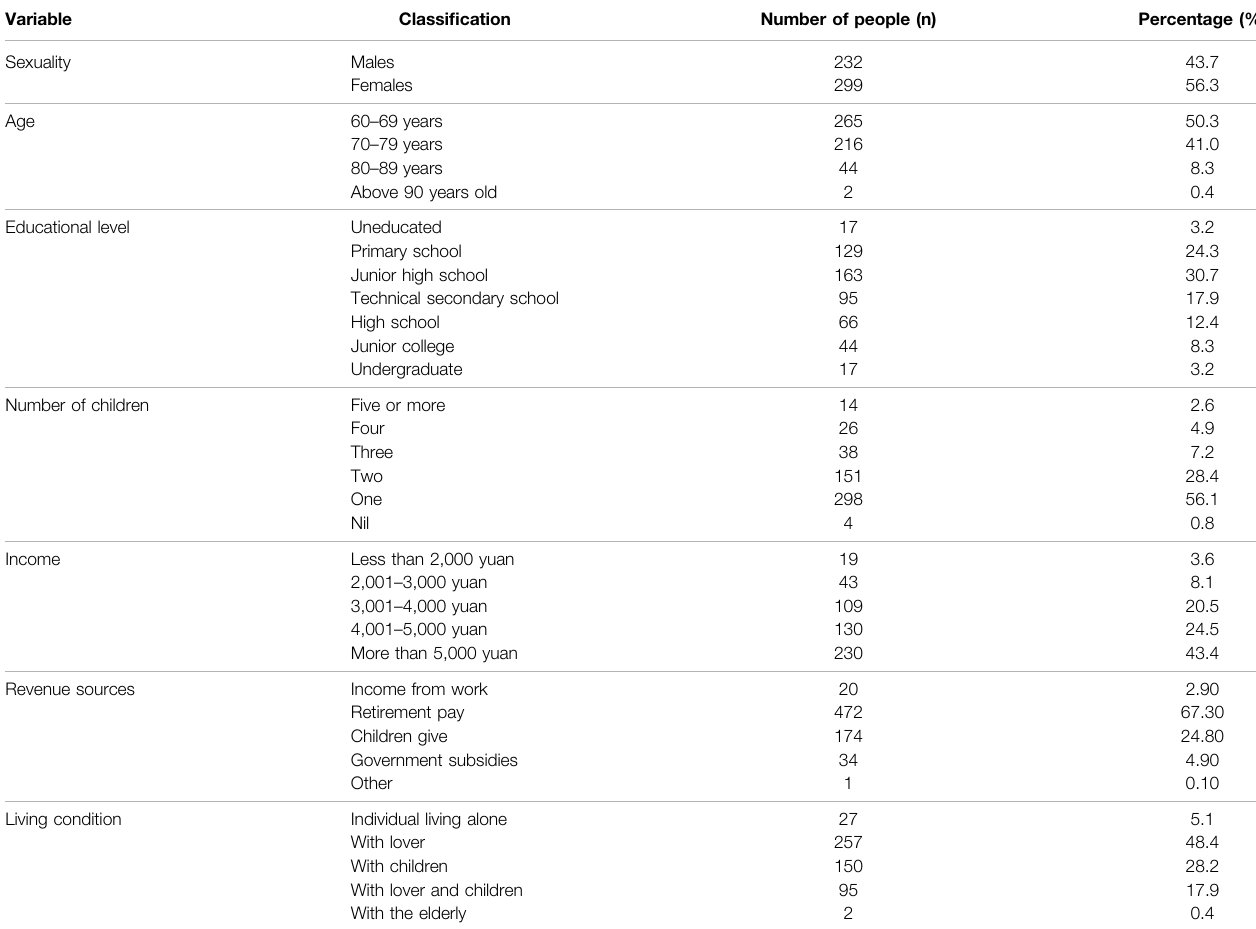
TABLE 1 | Descriptive statistics of demographic